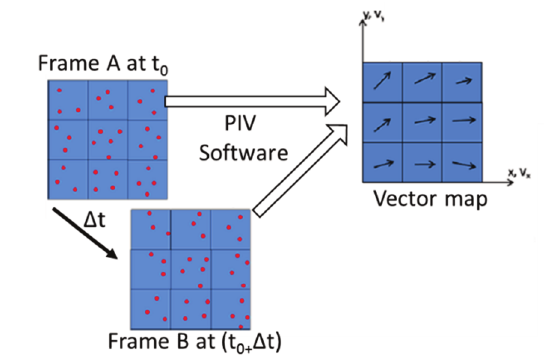
Fig. 15. The principle of using PIV in calculating the flow rate